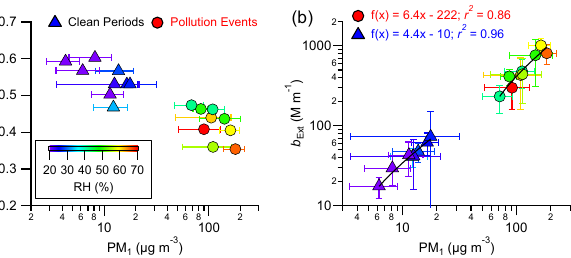
Figure 8. (a) Average mass fraction of organics ( f Org ) as a function of PM 1 mass, and (b) correlations of extinction coefficients (PM 2 . 5 ) vs. PM 1 for nine PEs and nine CPs marked in Fig. 1. The error bar represents 1 standard deviation of the average for each event.